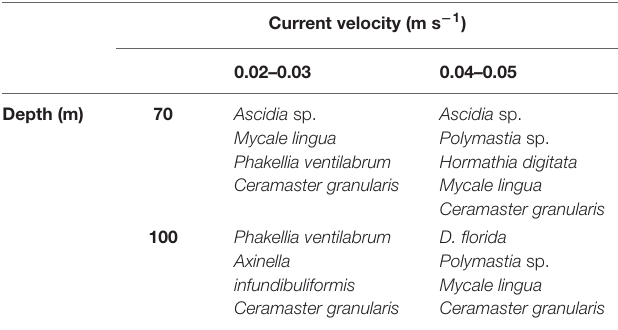
TABLE 2 | Table presenting the principal epifaunal taxa characterizing seafloor sites surveyed in Finnmark, northern Norway, at specific combinations of depth contours (m) and horizontal current velocities (0.02–0.05 m s − 1 ).